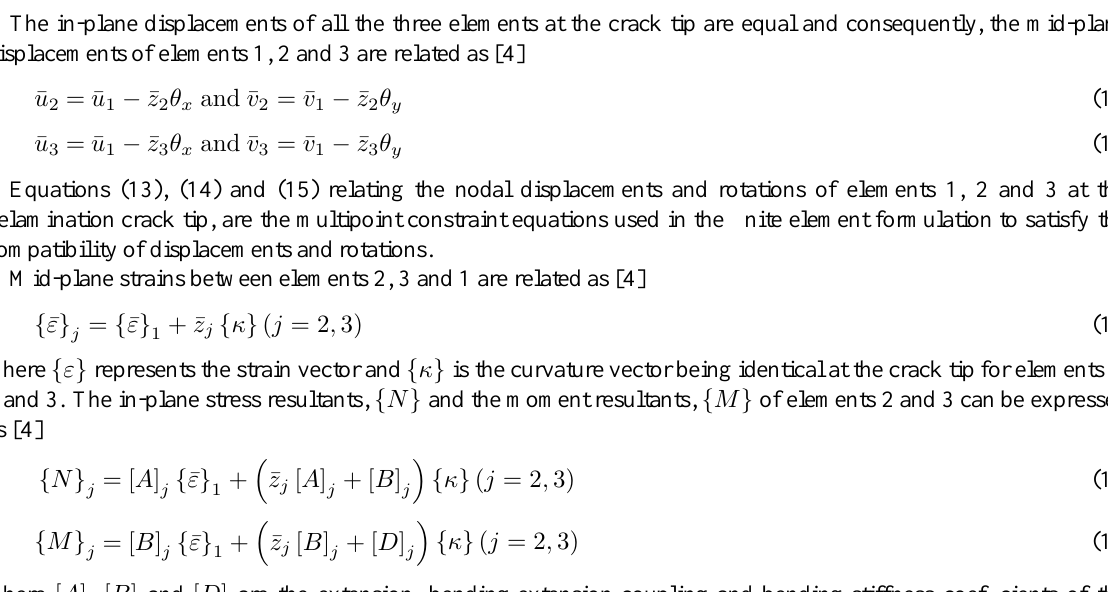
Fig. 2. Plate elements at a delamination crack